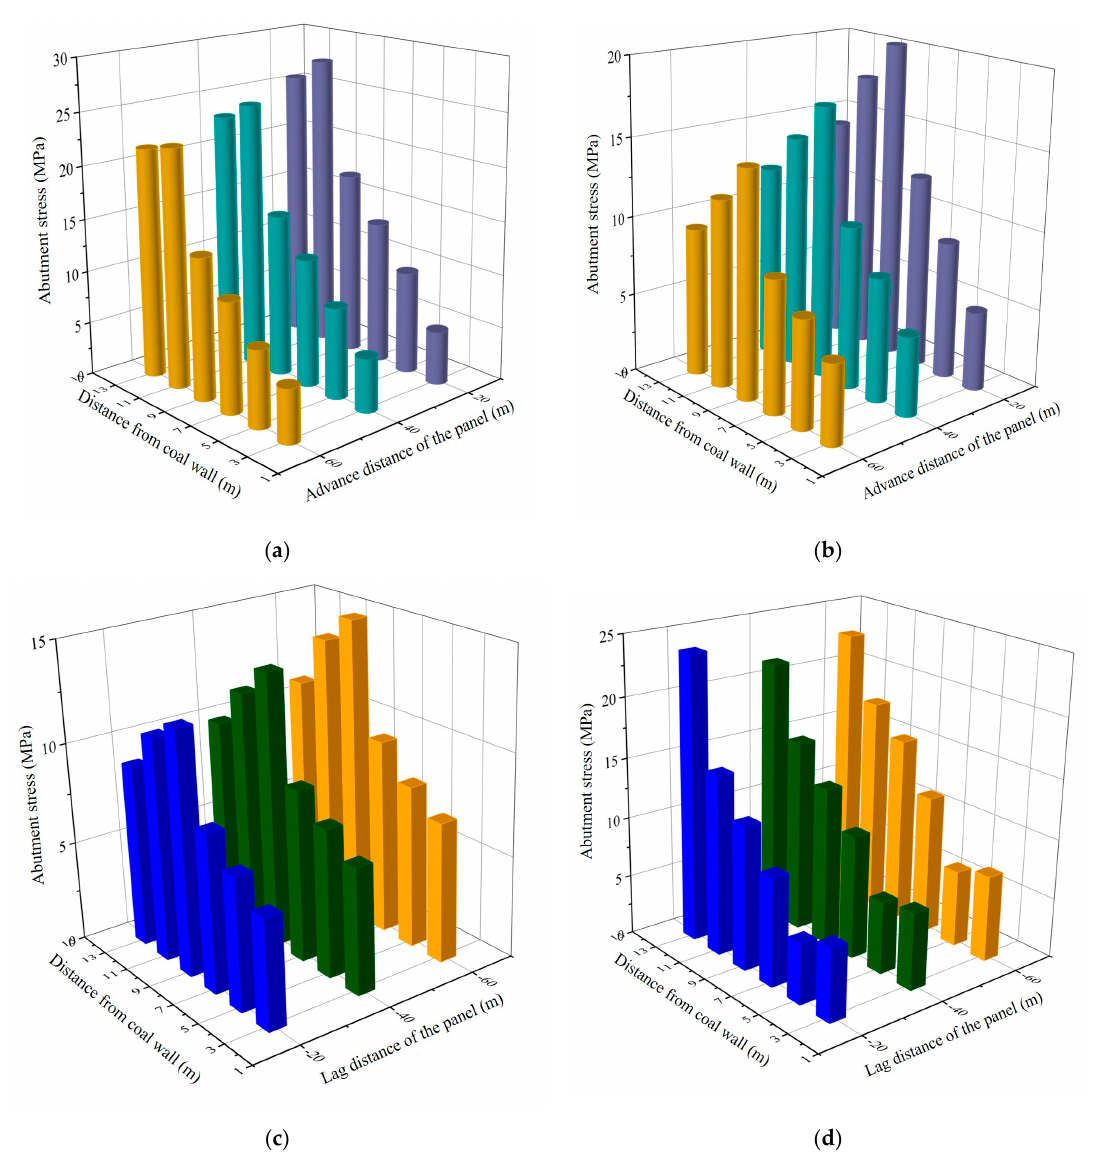
Figure 13. Abutment pressure distribution of coal mass with different depths at the side of solid coal in the tail entry and head entry and the relationship between the side abutment pressure and the working face distance: ( a ) Advanced side abutment pressure in the non-splitting entry (head entry). ( b ) Advanced side abutment pressure in the roof-splitting entry (tail entry). ( c ) Lagged side abutment pressure in the roof-splitting entry (tail entry). ( d ) Lagged side abutment pressure in the non-splitting entry (head entry).